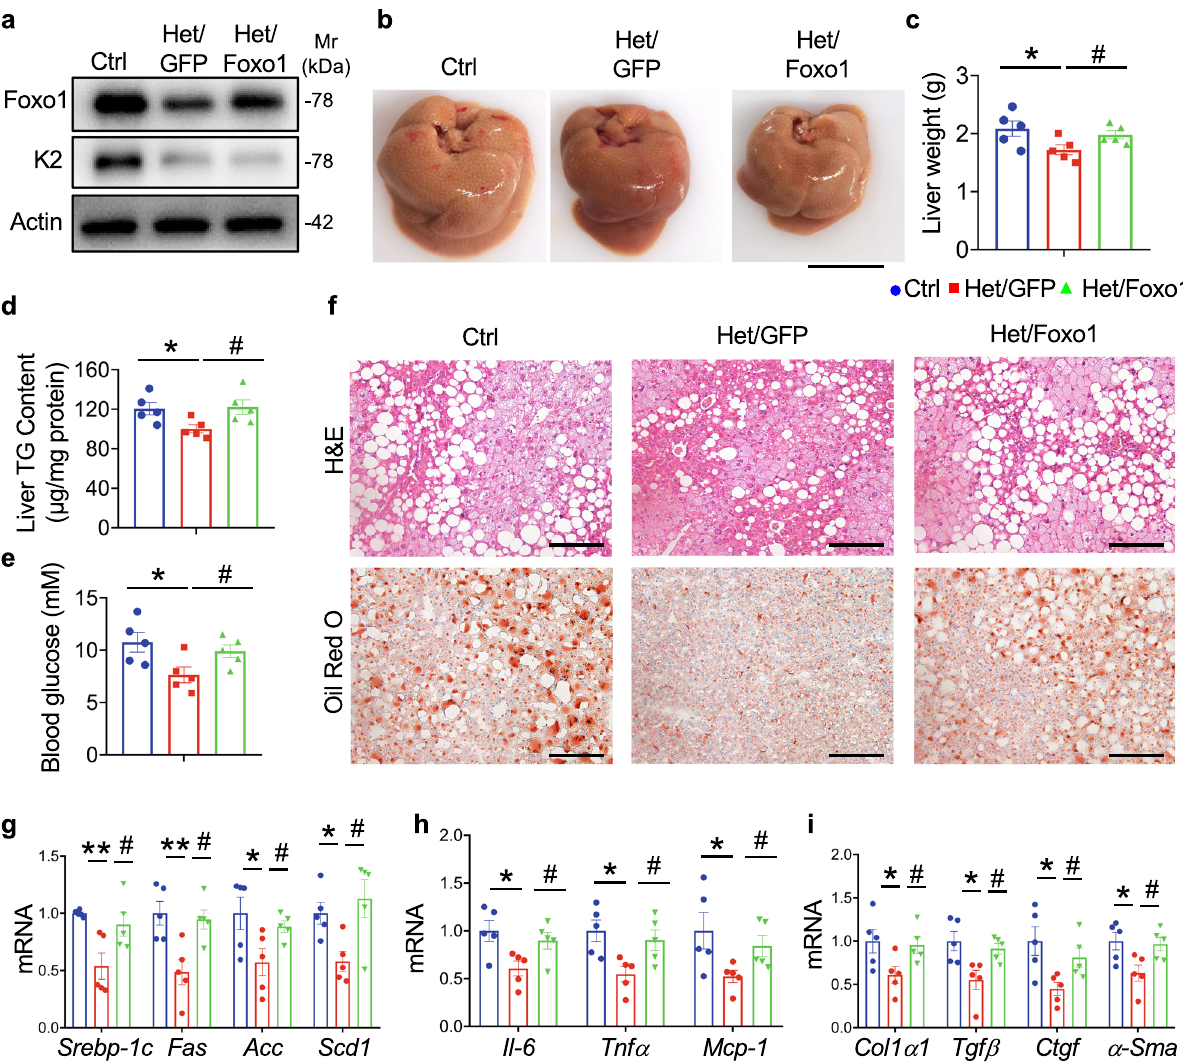
Fig. 7 Overexpression of Foxo1 abrogates the ameliorating effect of Kindlin-2 haploinsuf fi ciency on fat accumulation in the liver in mice. a Western blotting. Eight-week-old male Het mice were injected with and without AAV8-GFP (Het/GFP) or AAV8-Foxo1 (Het/Foxo1) and fed on HFD for 8 weeks. Liver extracts from each group were subjected to western blotting for expression of Kindlin-2 and Foxo1. Protein extracts (20 μ g) were used for western blotting from each sample. b , c Gross appearance ( b ) and liver weight ( c ) of the indicated groups ( n = 5). Scale bar, 1 cm. d Liver TG levels (normalized to liver weight) ( n = 5). e Serum glucose levels ( n = 5). f Representative images of H/E (top) staining and Oil Red O staining (bottom) of liver sections of the indicated groups. Scale bar, 100 μ m. g – i qRT-PCR analyses. mRNA expression levels of the indicated genes in liver samples from each group were determined ( n = 5). c – e , g – i Data are presented as mean ± SEM. * P < 0.05, ** P < 0.01, # P < 0.05, determined by two-tailed Student ’ s t- test. a , f Data are representative of three biologically independent